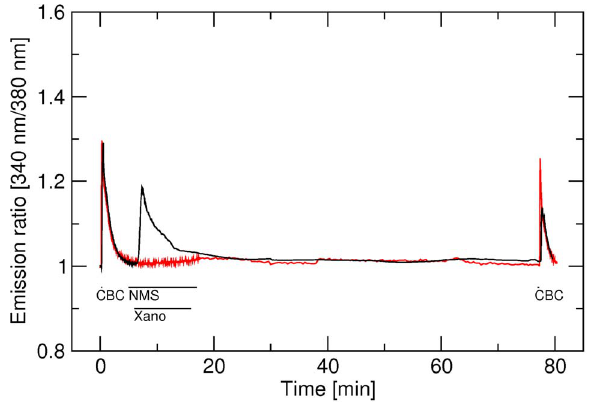
Figure 7. Lack of effects of changing extracellular calcium on calcium oscillations. Changes in the concentration of intracellular calcium (ordinate) are expressed as changes in normalized fluorescence intensity (340 nm/380 nm) ratio normalized to basal calcium level. Black trace: M 1 receptors, blue trace: M 4 receptors. First stimulation: Control 5-s stimulation with 300 nM carbachol (CBC) was performed. Second stimulation: After 6 min washing with KHB receptors were stimulated with 10 m M xanomeline for 3 min and then washed with calcium free KHB. Representative traces are averages of 12 best responding cells from one experiment. Signal variation (SD) among cells ranges from 6 0.015 at the base line to 6 0.063 at peaks. Results were confirmed in 2 additional independent